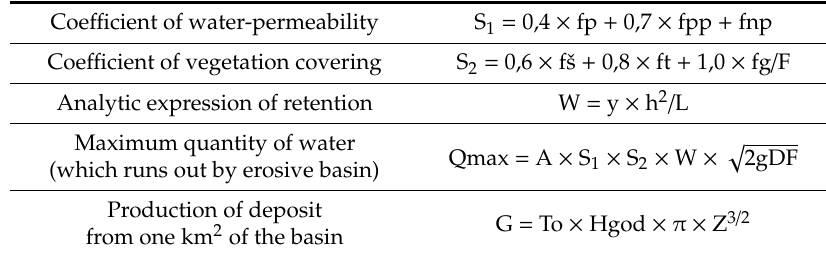
Table 2. Formula for analysis of geologic, hydro-geologic, pedologic and vegetation conditions of the